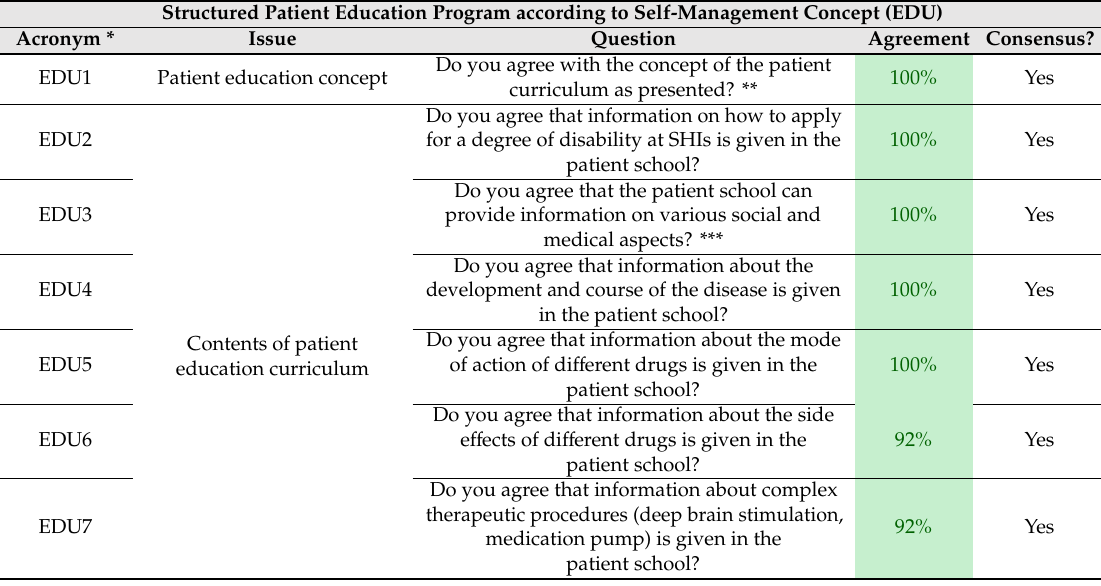
Table8. ResultsofTEDvoting—structuredpatienteducationprogramaccordingtoself-managementconcept. Structured Patient Education Program according to Self-Management Concept